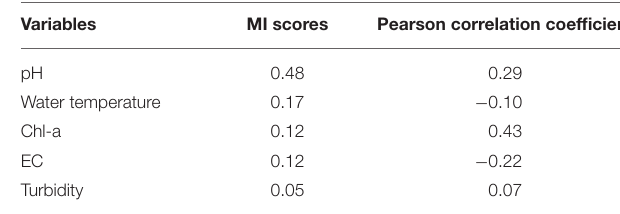
TABLE 2 | Correlation scores for each water quality variable against